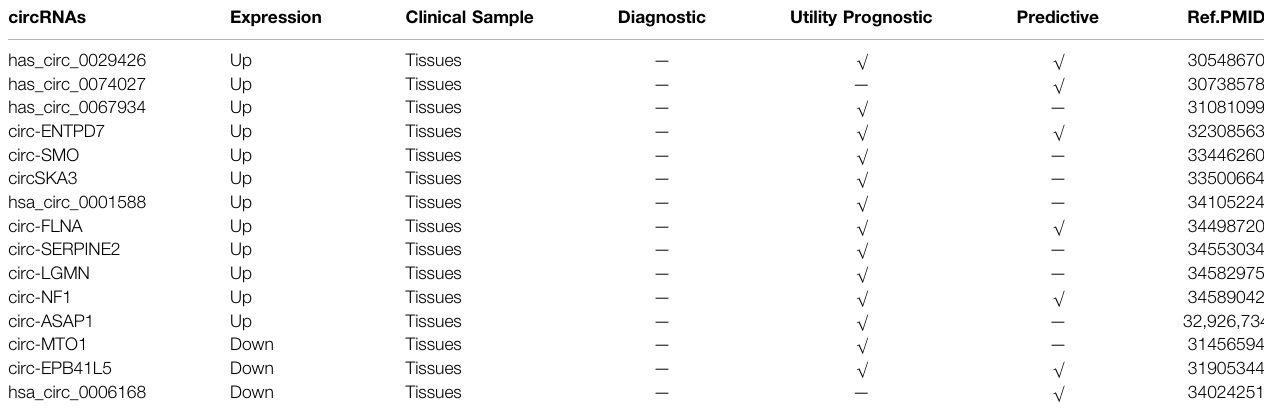
TABLE 3 | Utility of circRNAs for clinical of